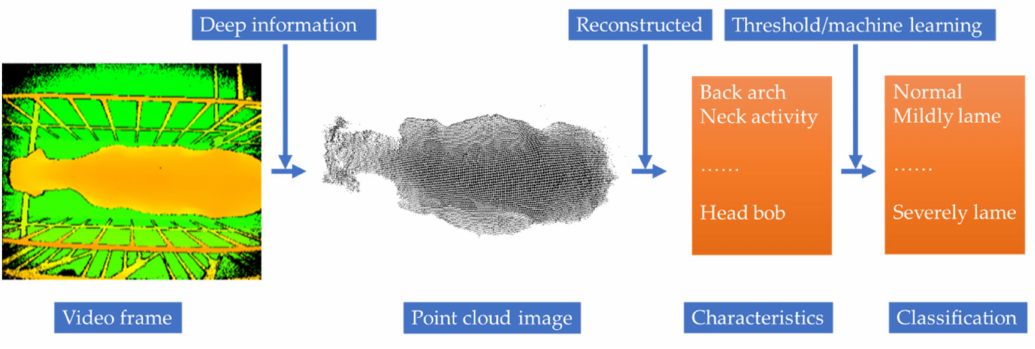
Figure 5. The detection process